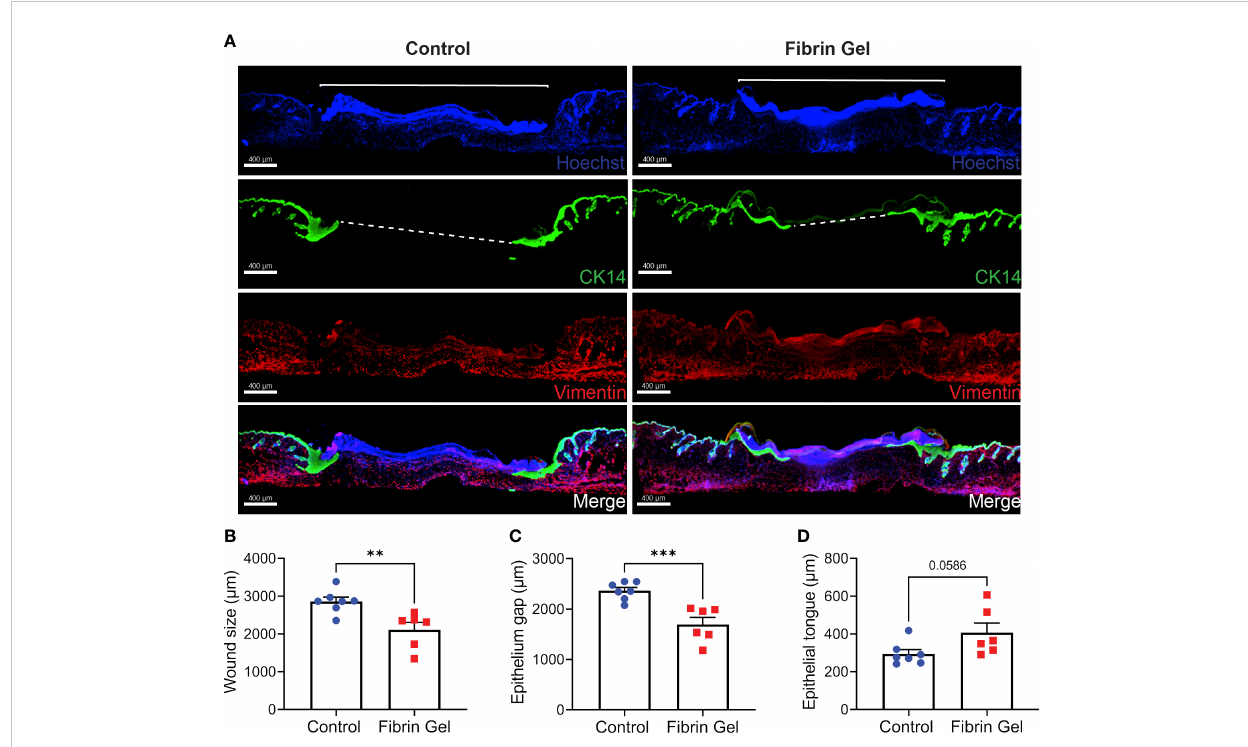
FIGURE 4 Migration of keratinocytes in wounds treated with fi brin hydrogel. (A) Immuno fl uorescence images of skin wound tissues harvested 3 days postinjury from wounds treated with fi brin hydrogel (Fibrin Gel) and in wounds left untreated (Control). Keratinocytes were stained with cytokeratin 14 (CK14, in green), DNA stained with Hoescht (in blue) and Vimentin in red. Immuno fl uorescence data analyzed by (B) wound size (bracket), (C) epithelium gap (striped line) and (D) epithelium tongue. **p<0.01, ***p<0.001. Each symbol represents the data from a single mouse. Scale bar: 400 µm. Data are shown as mean ±